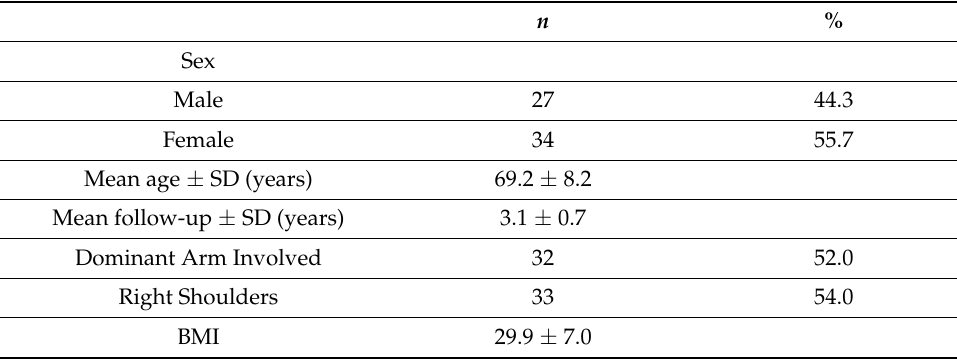
Table 1. Patient demographics ( N = 61).